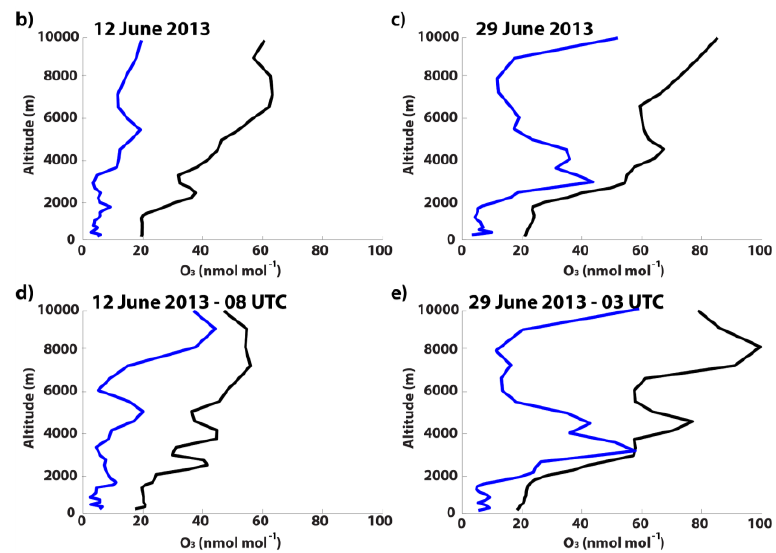
Figure 6. GEOS-Chem-predicted source contribution of O 3 (nmol mol −1 ) from long-range/stratospheric transport (black line) and just stratospheric transport based on GEOS-5 PVU (blue line) at the UAH TOLNet station. This figure displays ( a ) monthly averaged concentrations, daily-averaged concentrations for ( b ) 12 June 2013 and ( c ) 29 June 2013, and hourly-averaged concentrations at ( d ) 08 UTC on 12 June 2013 and ( e ) 03 UTC on 29 June 2013.